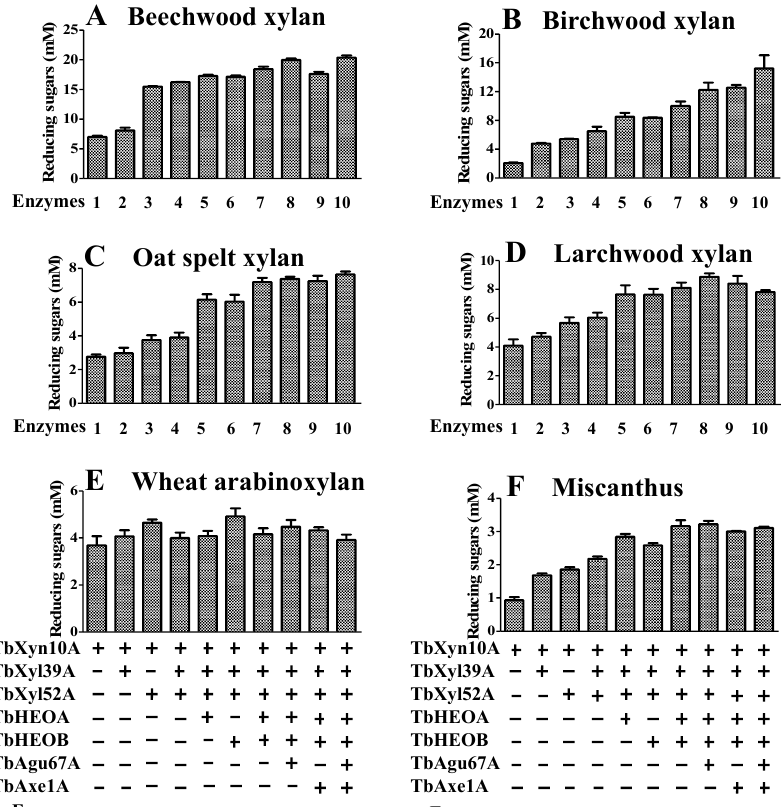
Figure 7. The synergistic effect of the seven enzymes encoded in the T. bryantii hemicellulase gene cluster during hydrolysis of heterogeneous xylans ( A – E ) and Miscanthus ( F ). The enzymatic reactions were carried out at 60 °C in a pH 5.5 citrate buffer supplemented with 1.0 mM of NADH and 1.0 mM of Mn 2+ . Substrates (BeeWX, BWX, LWX, and OSX) at 5 mg/mL were incubated with different combinations of the seven enzymes (10 nM TbXyn10A, 10 nM TbXyl39A, 5 nM TbXyl52A, 100 nM TbAgu67A, 100 nM TbAxe1A, 50 nM TbHEOA, and 50 nM TbHEOB) for 16 h. In the case of WAX, a lower concentration of substrate (2.5 mg/mL) was incubated with a lower concentration of enzymes (5 nM TbXyn10A, 5 nM TbXyl39A, 2.5 nM TbXyl52A, 50 nM TbAgu67A, 50 nM TbAxe1A, 25 nM TbHEOA, and 25 nM TbHEOB) for 16 h. Miscanthus was incubated at a higher substrate loading (10 mg/mL of Miscanthus) with higher concentrations of enzymes (1 µM TbXyn10A, 0.5 µM TbXyl39A, 0.5 µM TbXyl52A, 2 µM TbHEOA, 2 µM TbHEOB, 2 µM TbAgu67A, and 2 µM TbAxe1A) for a longer period of 21 h. The released reducing sugars were determined using the p HBAH method.